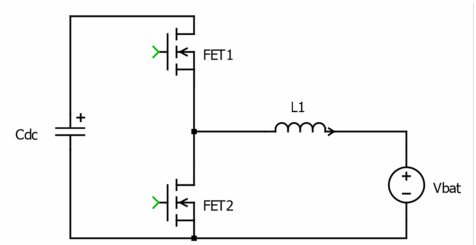
Figure 4. Bidirectional Converter for modelling the battery and vehicle subsystems.